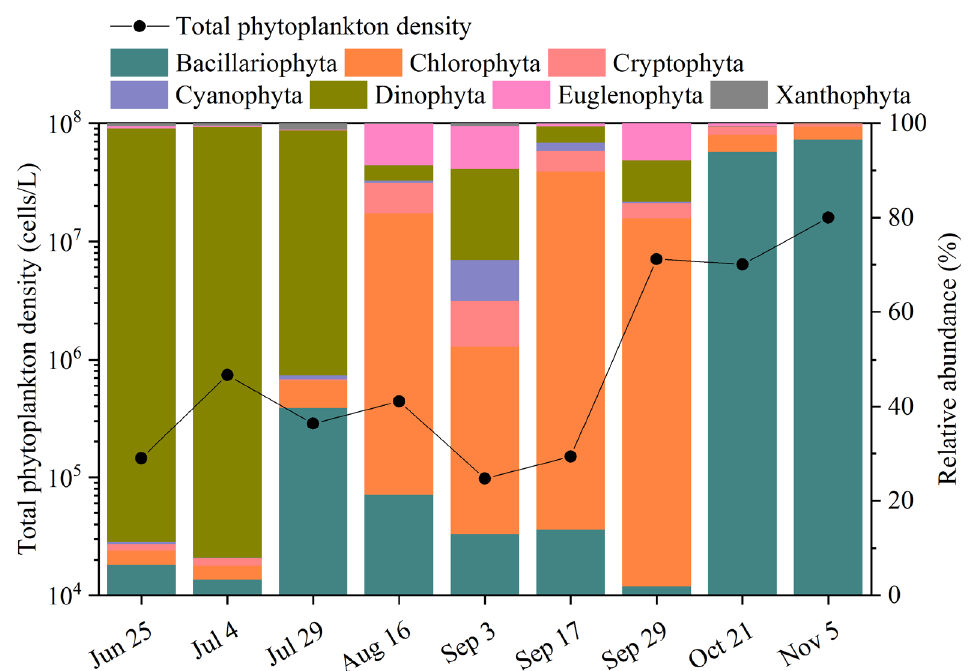
Figure 3. Morphological analysis of the temporal variation in total phytoplankton density and relative abundance in bivalve aquaculture water samples.